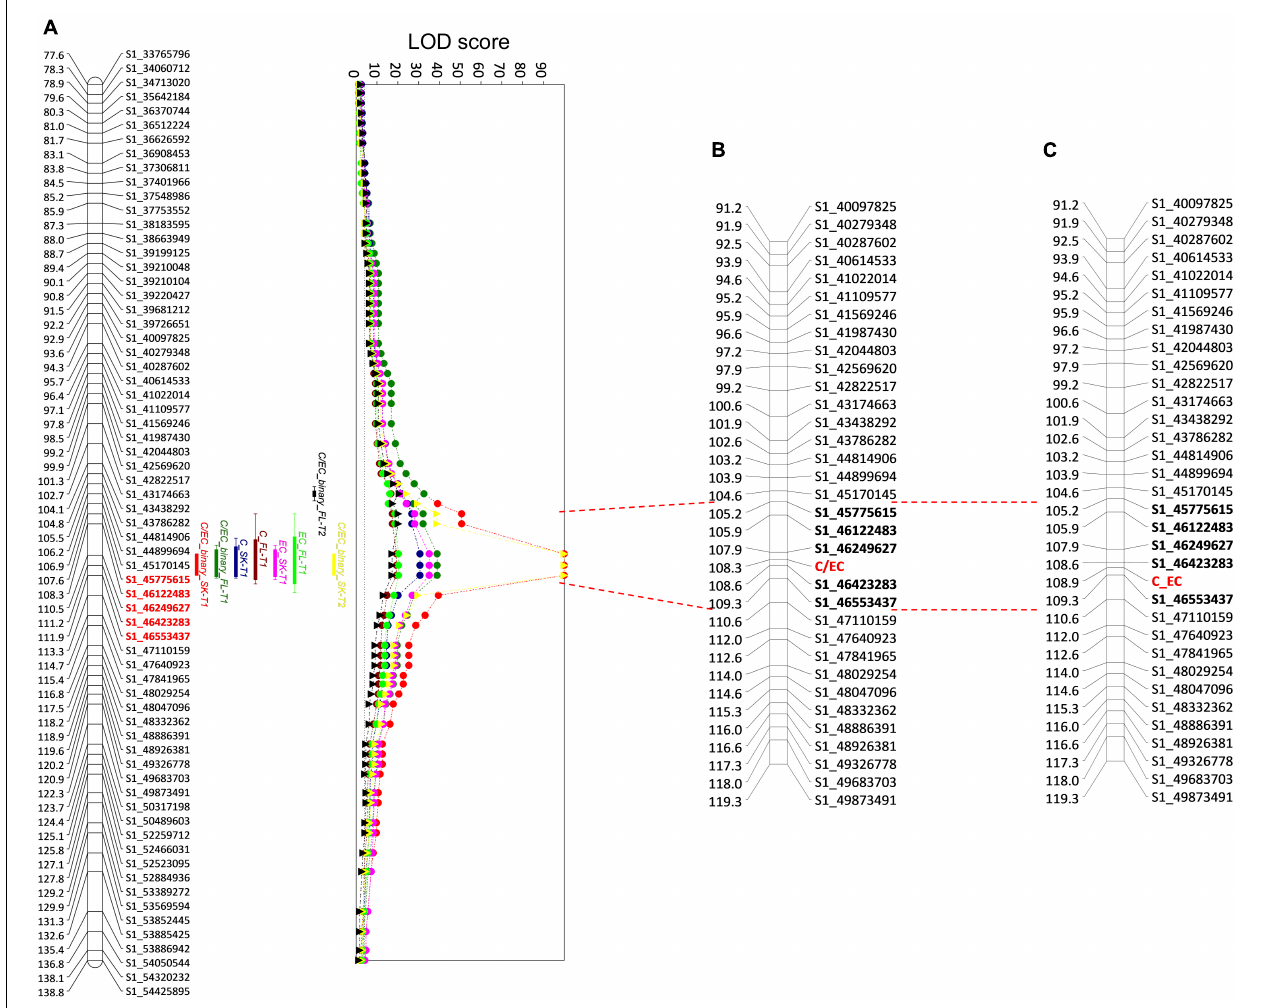
FIGURE 6 | Quantitative trait loci (QTL) analysis of C and EC in ‘Angeleno’ (A) and linkage map including the C/EC metabolic marker in T1 (B) and T2 (C) . Each QTL corresponds to an independent trait from the skin (SK) and the flesh (FL) of the fruits in T1 (circles) and T2 (triangles). C, catechin; EC, epicatechin. QTLs for C and EC are shown only in T1, corresponding to the relative contents in the tissue. On the left side of the LG, the genetic position (cM) of each marker is indicated. On the right side, the name of each marker associated with a genetic position is indicated. The graph on the right indicates the LOD scores of the QTLs detected. The gray dotted line is the LOD score threshold for significant QTLs. Red lines extending from the QTL graph to the linkage maps with the C/EC marker denote the interval containing the markers (in bold) with the largest LOD scores. The name of the SNPs indicates the corresponding LG and the physical position according to the Prunus salicina Lindl. reference